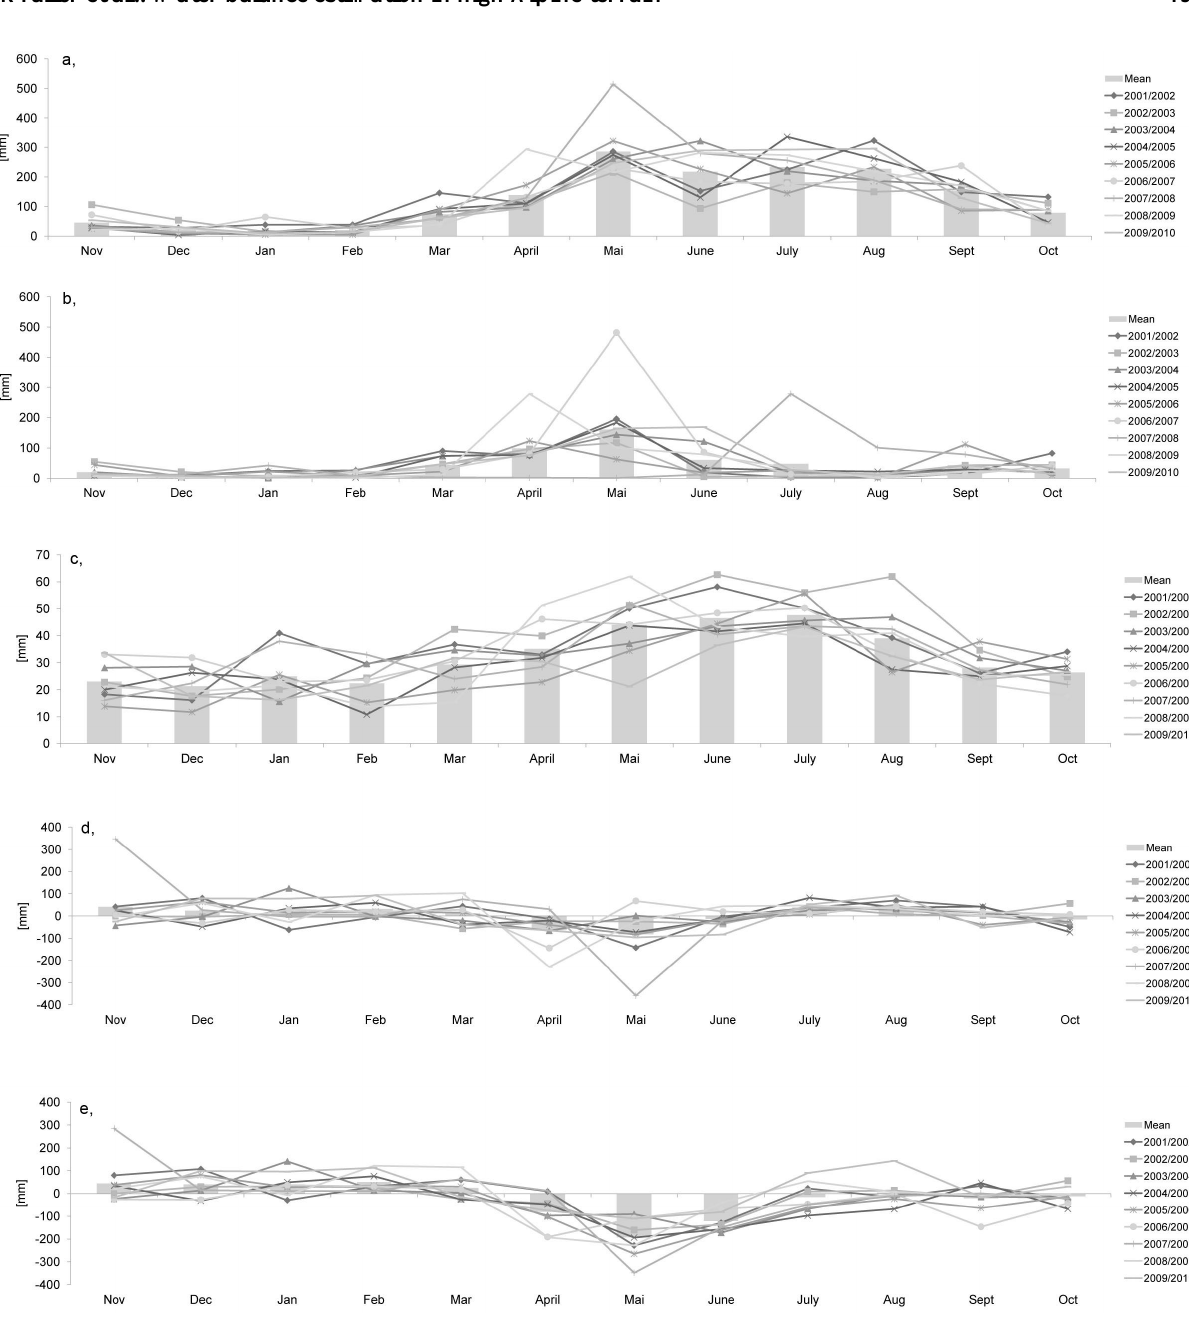
Fig. 10. Monthly sums of snowmelt+rain (a) , snowmelt (b) , evapotranspiration (c) , water storage of the hydrological model (d) and observed water storage (e) for hydrological years 2001–2010 in subbasin